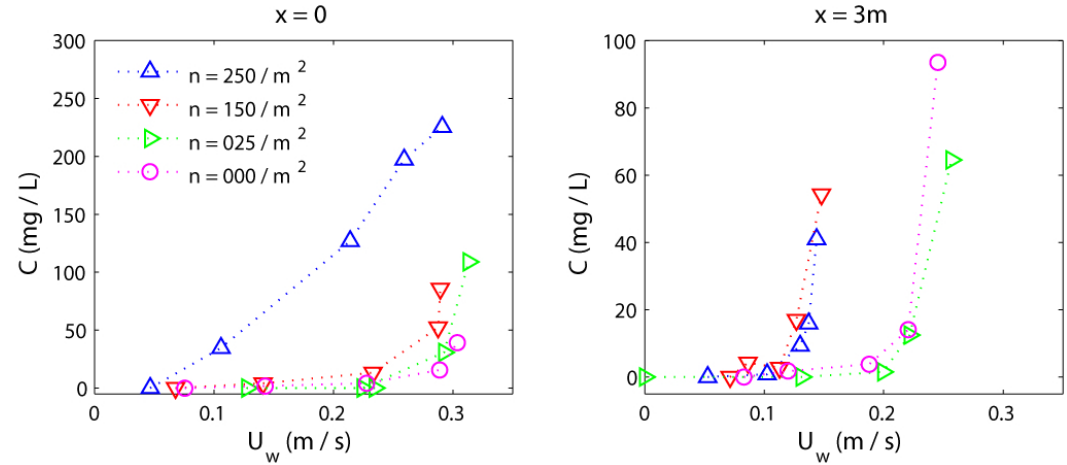
Figure 12. Mean concentrations against measured near-bottom orbital speed for all densities at two instrumented locations. Notice the di ff erent vertical